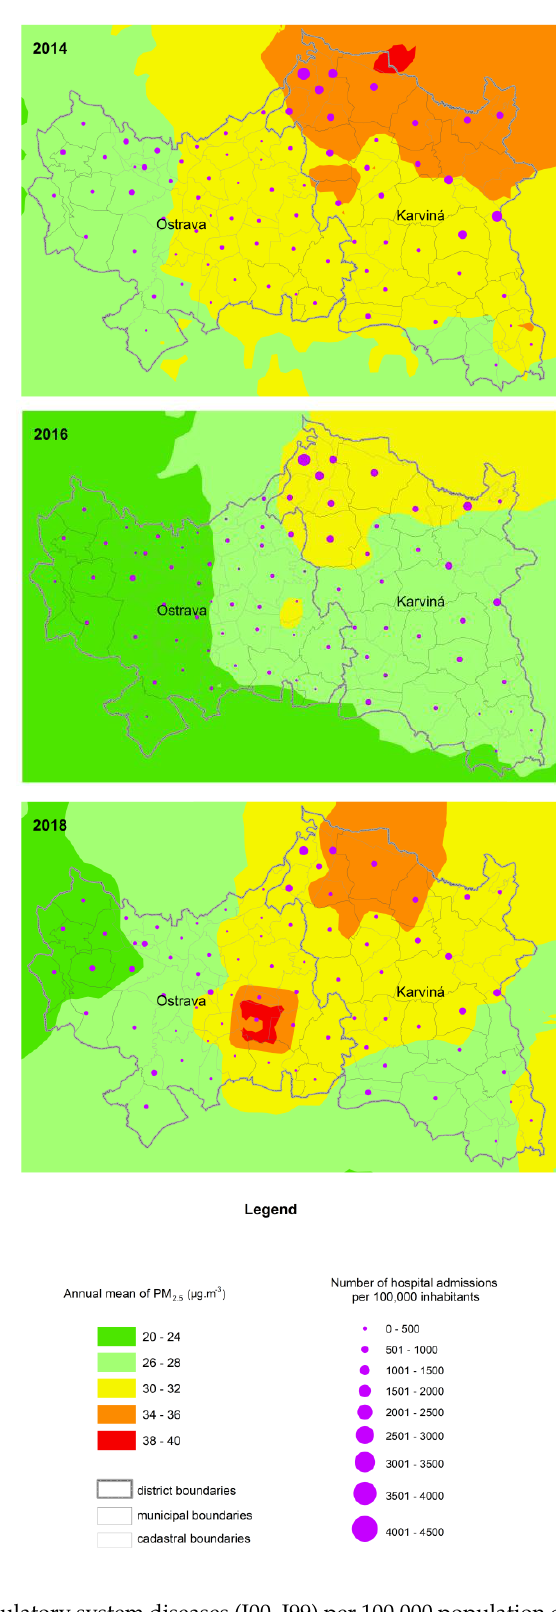
Figure 2. Hospital admissions for circulatory system diseases (I00–I99) per 100,000 population during the individual years of the study period.